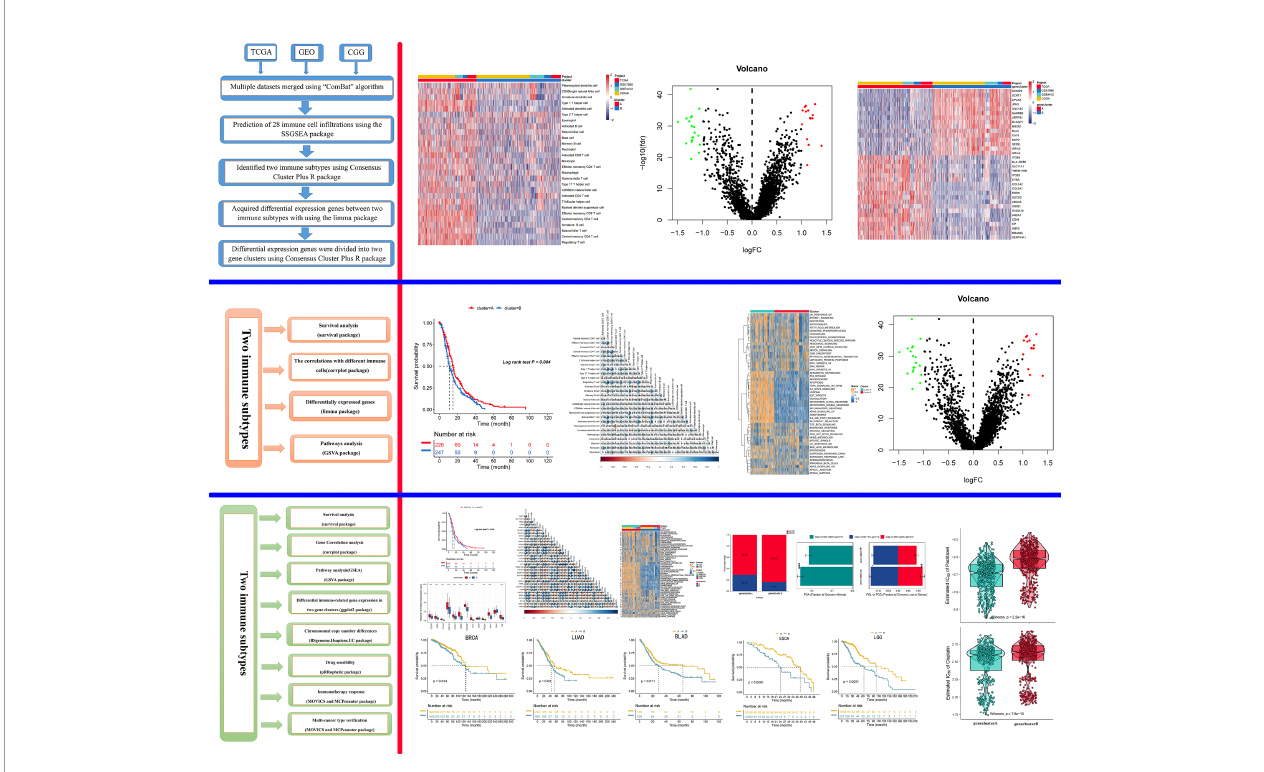
FIGURE 6 | Graphical abstract. The model of a complex multi-omics regulation of the tumor immune phenotype in